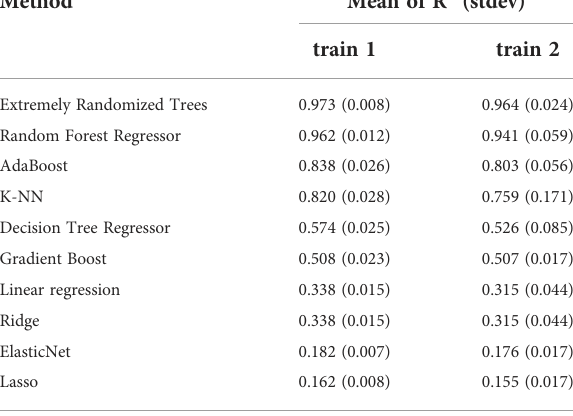
TABLE 2 Mean and standard deviation (in brackets) of R 2 score obtained from k-cross validation for each model and each dataset (train1 and train2) sorted in descending order.